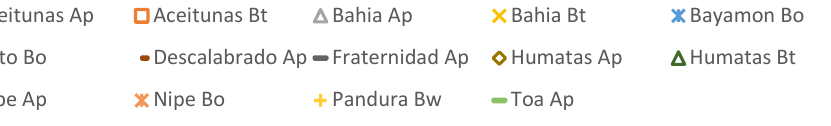
Figure 4. Cumulative distributions of K sat values in the soil horizons studied. The parameters K 16.5 , K 50 and K 83.5 are K sat values corresponding to the cumulative distribution percentiles 16.5, 50, and 83.5, respectively. The parameters K 83.5 and K 16.5 constitute the upper and lower bounds of the middle 67 percent of all K sat values, i.e., the percent of values residing within one geometric standard deviation of the geometric mean. Table 5 lists the soil horizons evaluated, the number N of K sat measurements per horizon, the rated K sat class in the USDA-NRCS system, the measured geometric mean of K sat , the geometric standard deviation, the respective upper and lower geometric standard deviation bounds K 83.5 and K 16.5 , and the ratios K 83.5 K 16.5